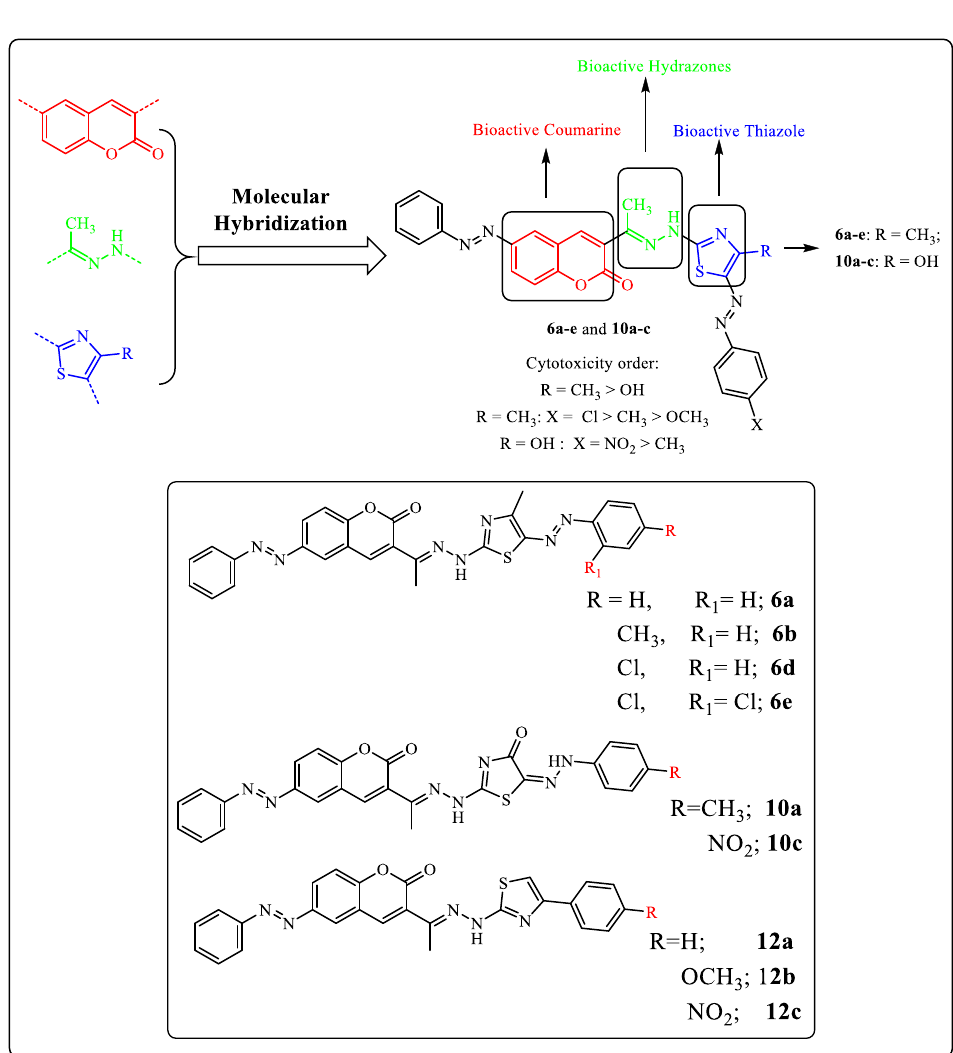
Figure 6. SAR of the synthesized thiazoles.